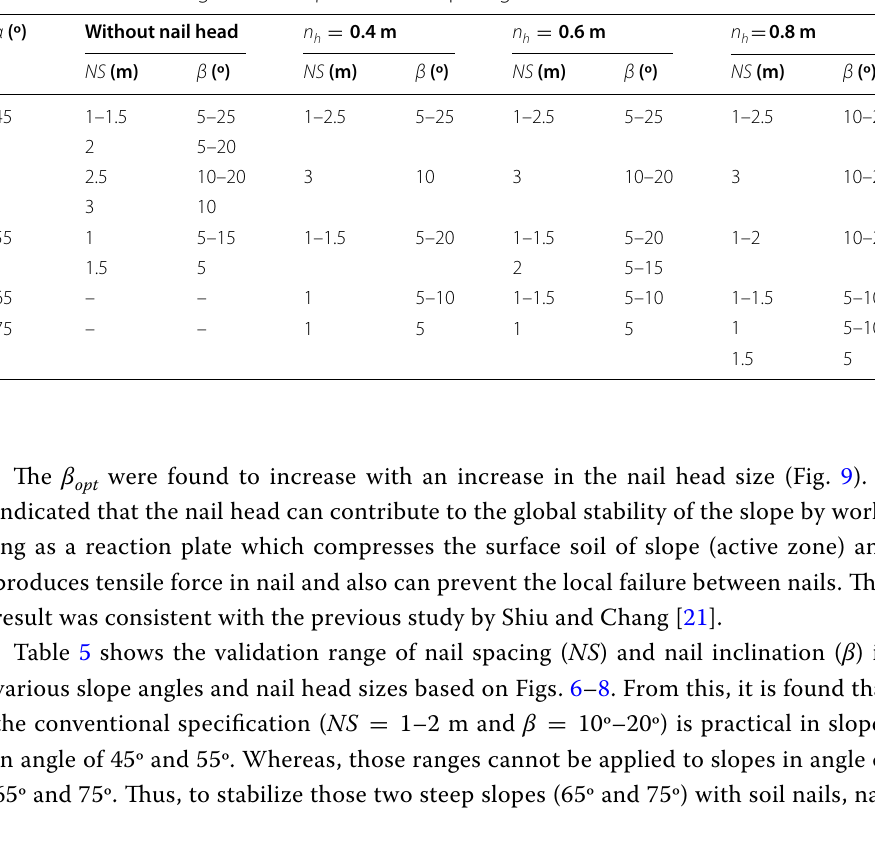
Table 5 Validation range of NS and β in various slope angles and nail head